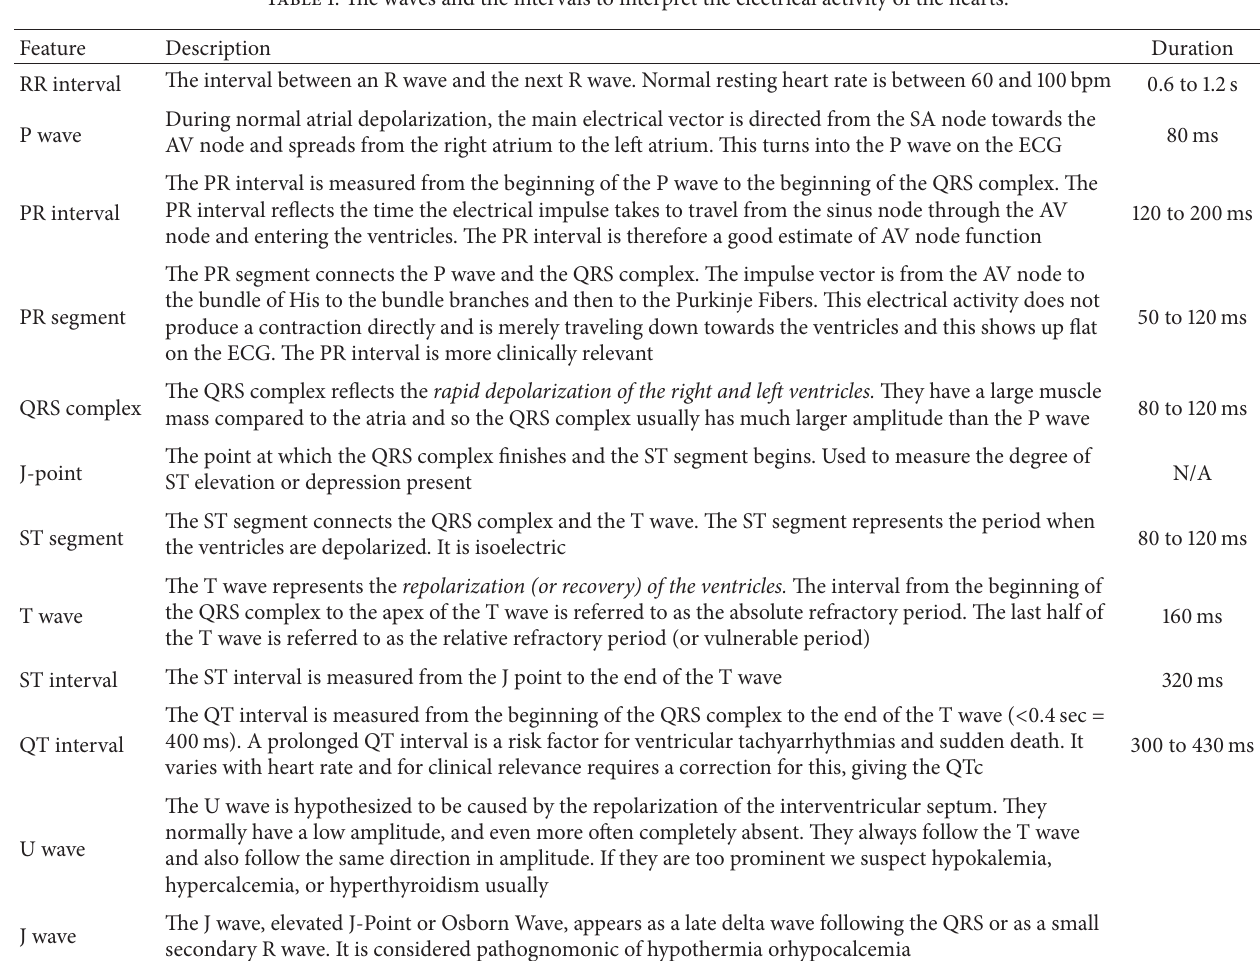
Table 1: The waves and the intervals to interpret the electrical activity of the